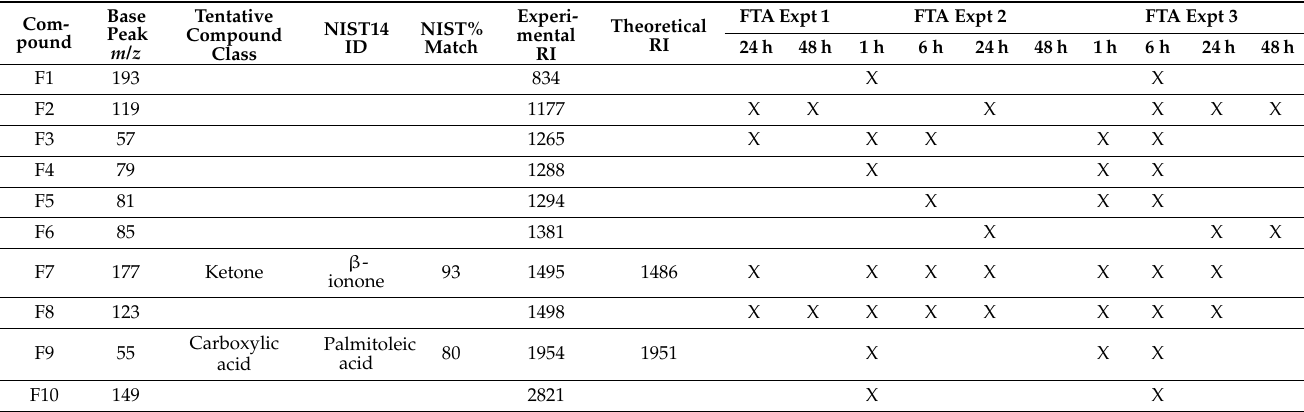
Table 2. Putative biomarkers emitted only after freeze–thaw damage to Microchloropsis gaditana cultures and not present in time-matched, healthy M. gaditana